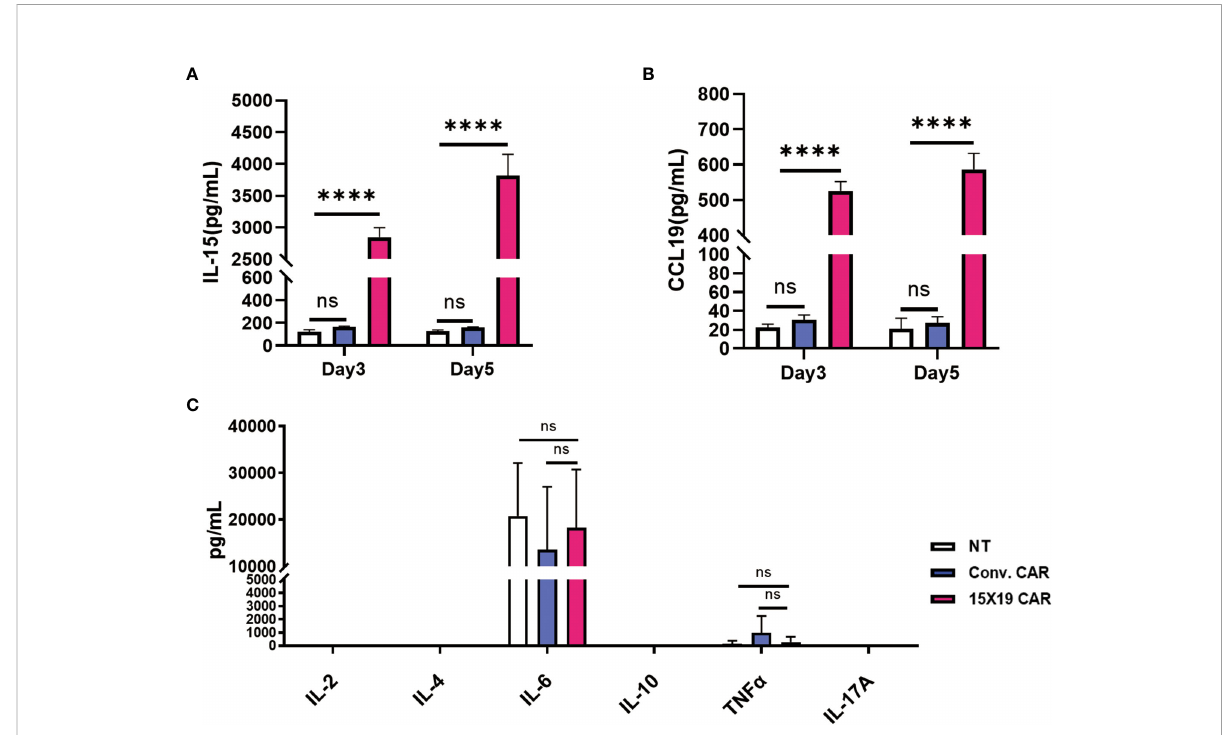
FIGURE 6 15 × 19 CAR T cells promote IL-15 and CCL19 secretions. Cells in the NT, conventional CAR and 15 × 19 CAR groups are co-cultured with mitomycin C-treated HCG-27 cells at a ratio of 1:1 for 3 or 5 days, and the IL-15 and CCL19 levels are detected in the culture supernatant using ELISA assay. (A) , A higher IL-15 level is detected in the 15 × 19 CAR group than in the NT and conventional CAR groups; (B) , A higher CCR19 level is detected in the 15 × 19 CAR group than in the NT and conventional CAR groups; (C) , Following co-culture of effector cells and mitomycin C-treated HCG-27 cells at a ratio of 1:1 for 5 days, the greatest IL-6 level is detected; however, no signi fi cant difference is seen among the three groups ( P > 0.05). Low IL-2, IL-4, IL-10, TNF- a and IL-17A levels are detected, with no signi fi cant difference detected among the three groups ( P > 0.05). Representative data are captured from three independent experiments. One-way ANOVA with multiple comparisons test. ns , no signi fi cant difference; **** P <